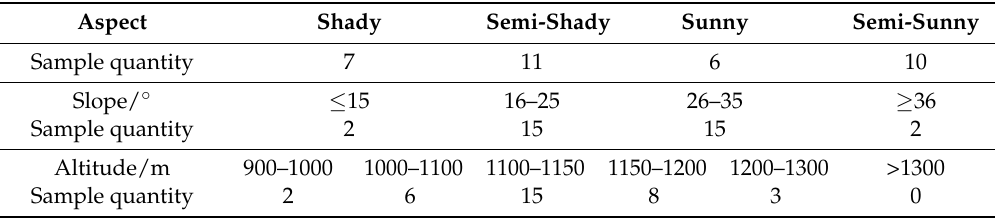
Table 1. The distribution of aspects, slopes, and altitudes of the sample plots in the Caijiachuan Watershed.